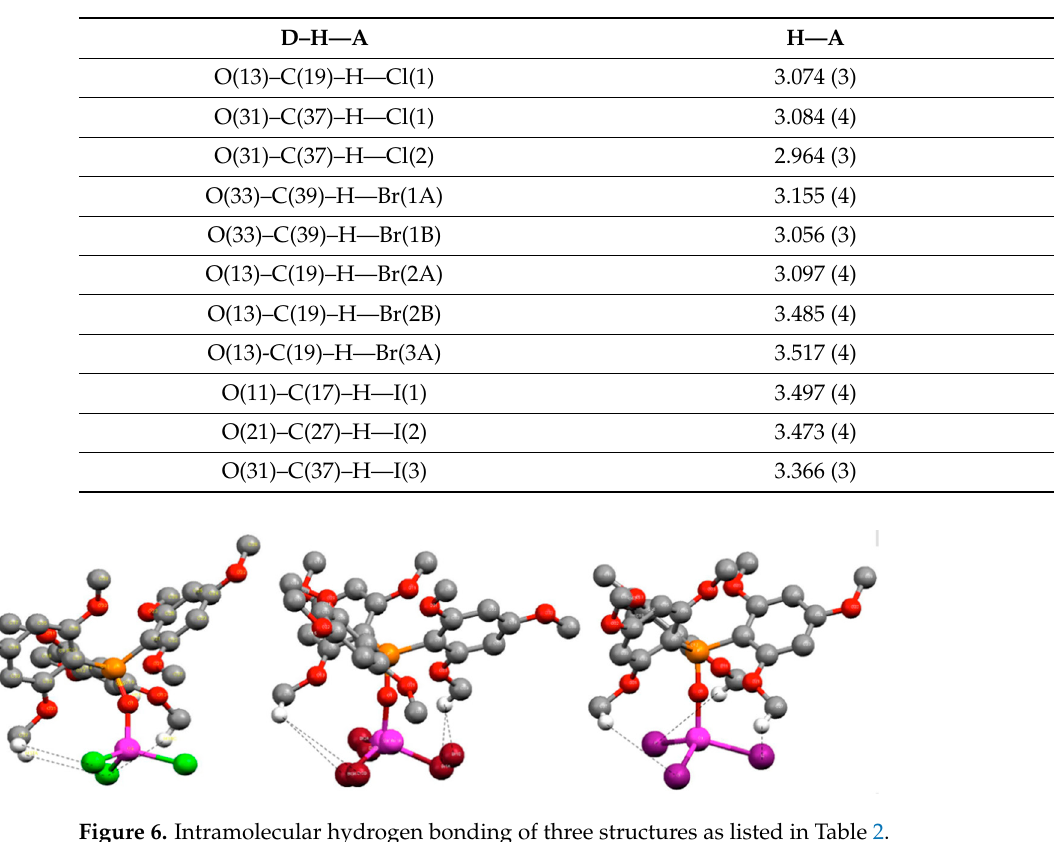
Figure 5. Overlay of two molecular structures. ( a ): the Cl/I and ( b ): the Cl/Br adducts structures. The major (90%) and minor (10%) conformers were also present in a GaBr 3 –phosphine complex in our previous work [10], but not in crystal structures of Cl − and I − anion also (Figure 4b).